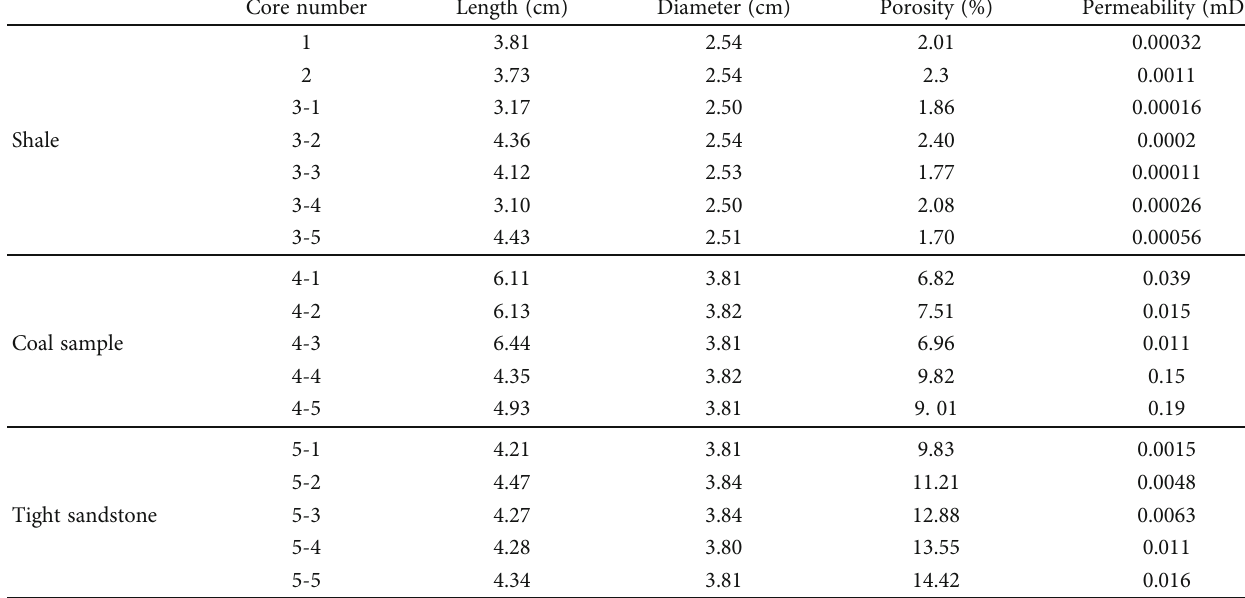
Table 1: Basic physical parameters of experimental